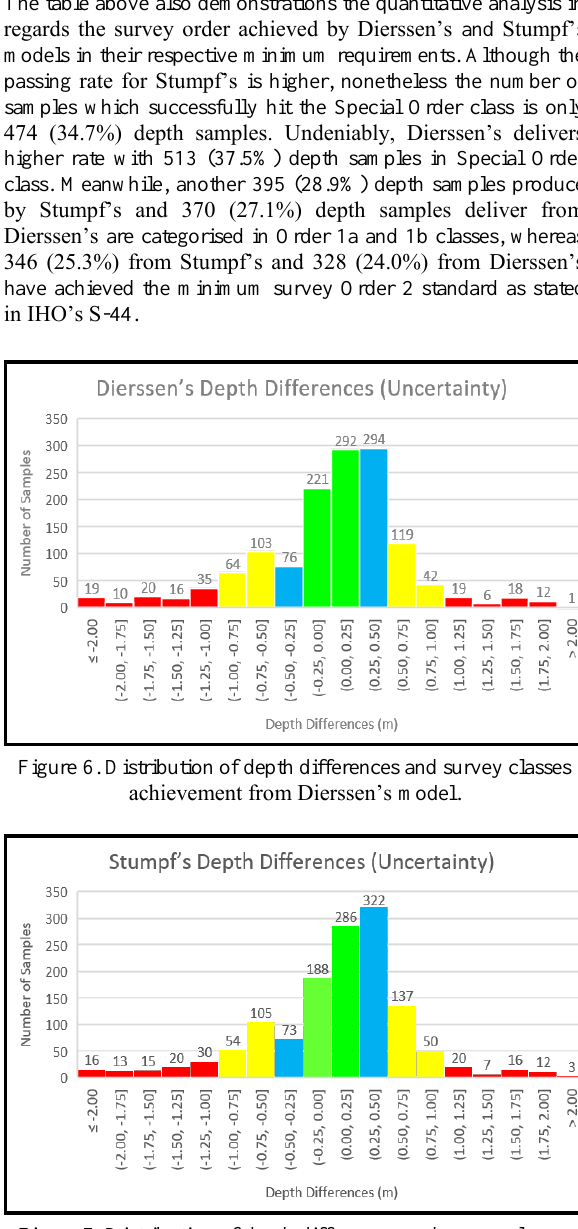
Figure 7. Distribution of depth differences and survey classes achievement from Stumpf’s